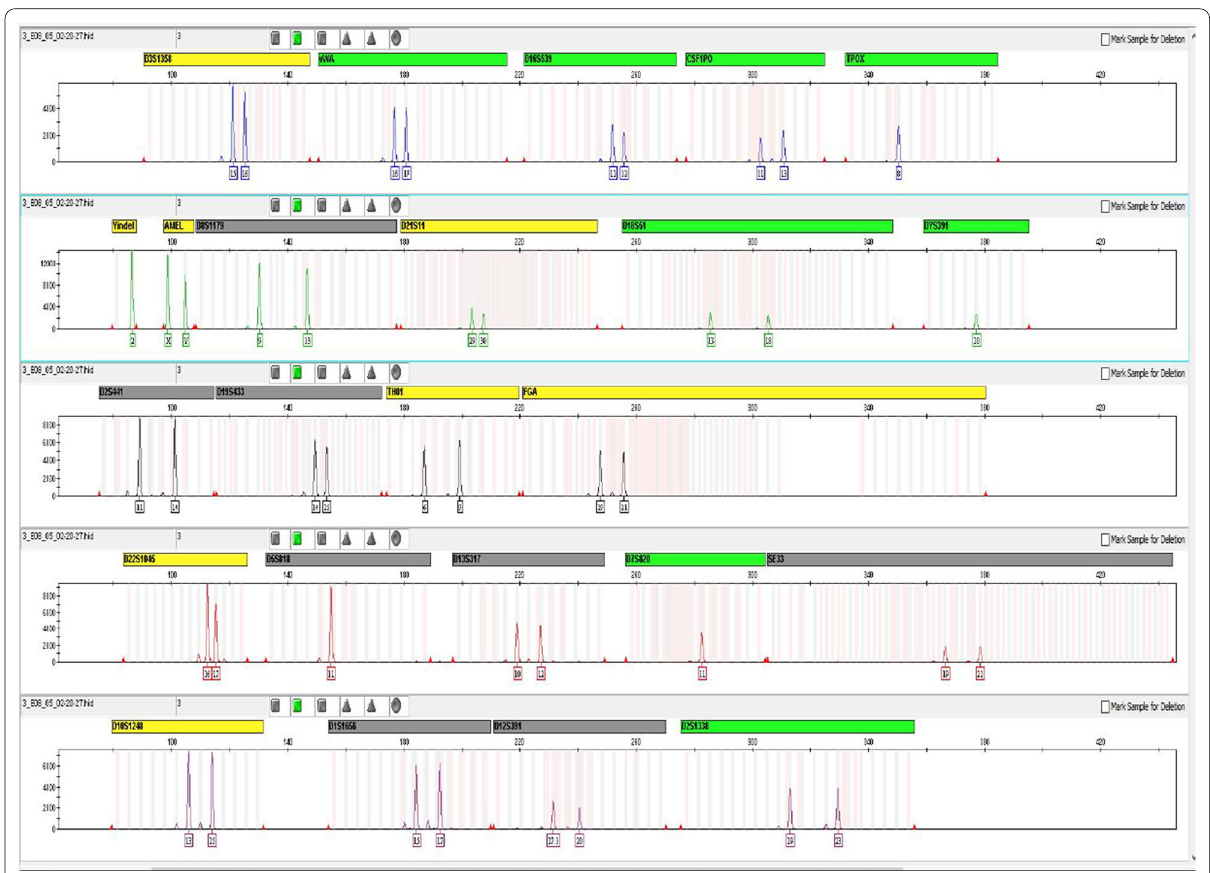
Fig. 7 DNA profile of blood stain in washed cotton fabric at 60 °C extracted by organic DNA extraction